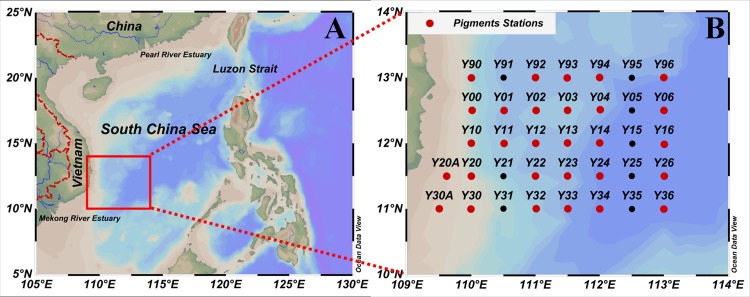
Maps of the study area (A) and location of sampling sites (B) during the September 2007 cruise. The red dots indicate the 29 stations where the phytoplankton pigment survey was carried out during the cruise.